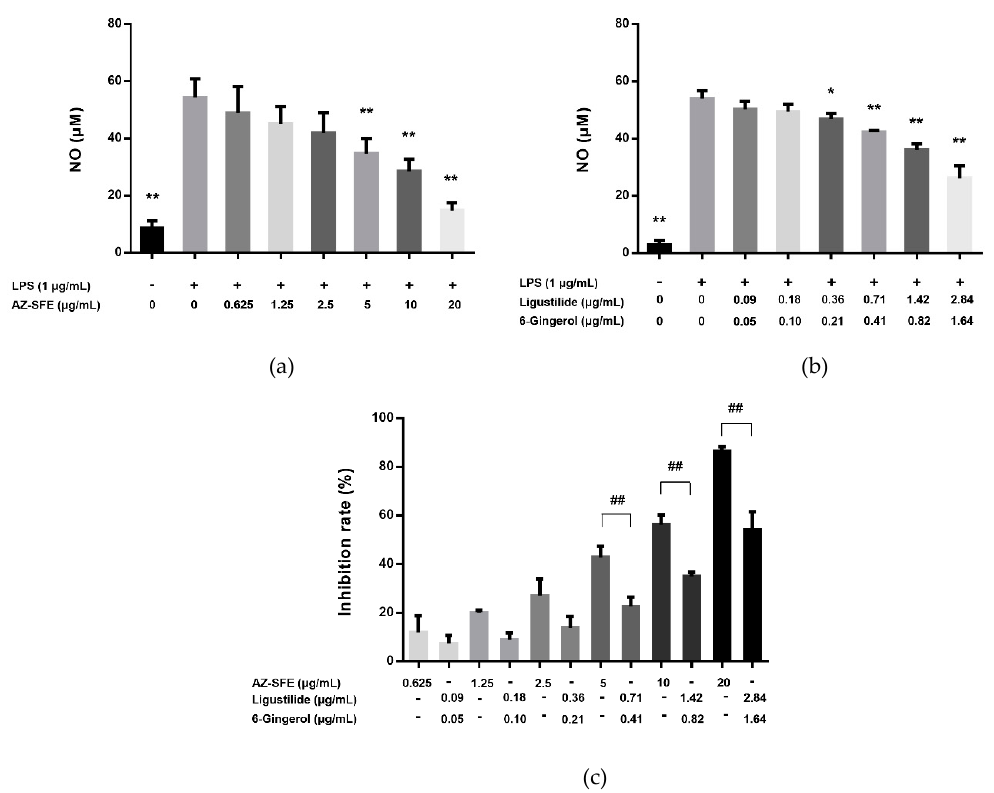
Figure 3. Effects of AZ-SFE and a combination of ligustilide and 6-gingerol on NO production in lipopolysaccharide (LPS)-induced RAW264.7 cells. Cells were pretreated for 1 h in the presence or absence of ( a ) AZ-SFE or ( b ) the combination of ligustilide and 6-gingerol, in a ratio according to their content in AZ-SFE, and then stimulated with LPS (1 μ g/mL) for 24 h. ( c ) The inhibition rate was calculated by the formula indicated in Section 4.7. Data are expressed as mean ± SD ( n = 3) of three independent experiments. * p < 0.05 and ** p < 0.01 versus LPS group. ## p < 0.01 between two compared groups.